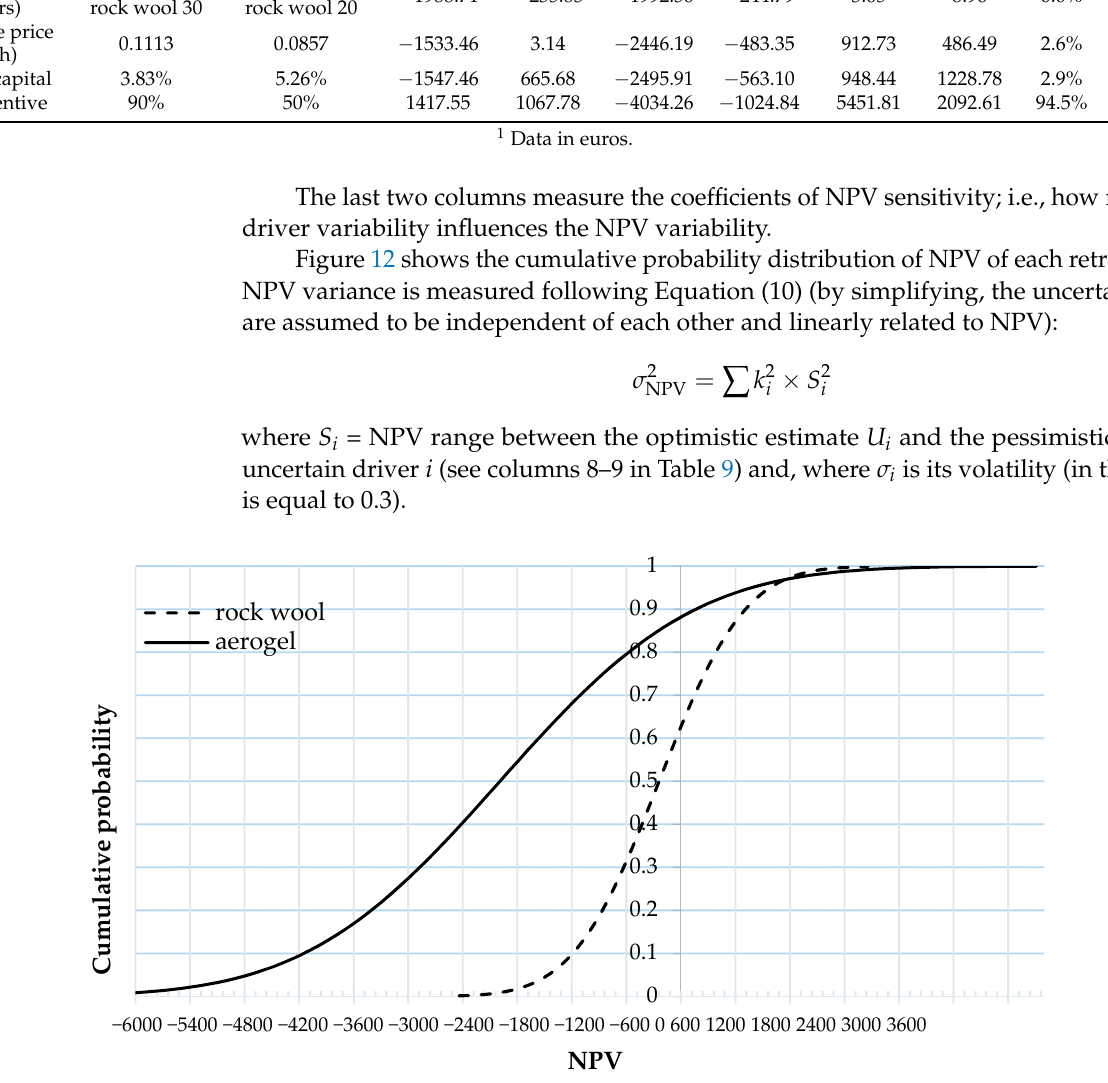
Figure 12. NPV cumulative probability distributions of retrofit with aerogel and rock wool.